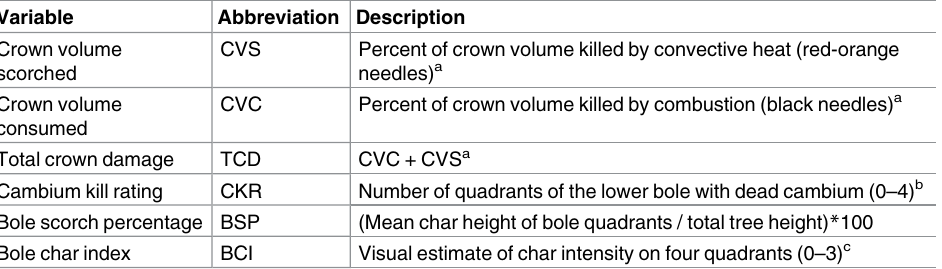
Table 1. Fire injury measuresrecorded on each